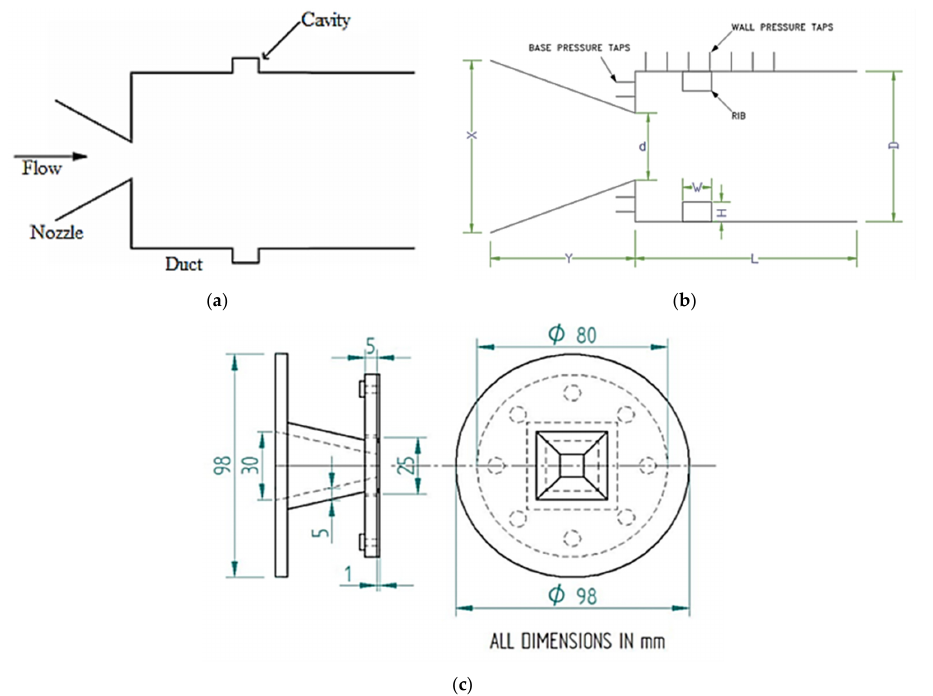
Figure 3. Passive control devices: ( a ) cavities [37], ( b ) ribs [38], and ( c ) cylinders [39,40]. Reprinted under the Creative Commons (CC) License (CC BY 3.0).